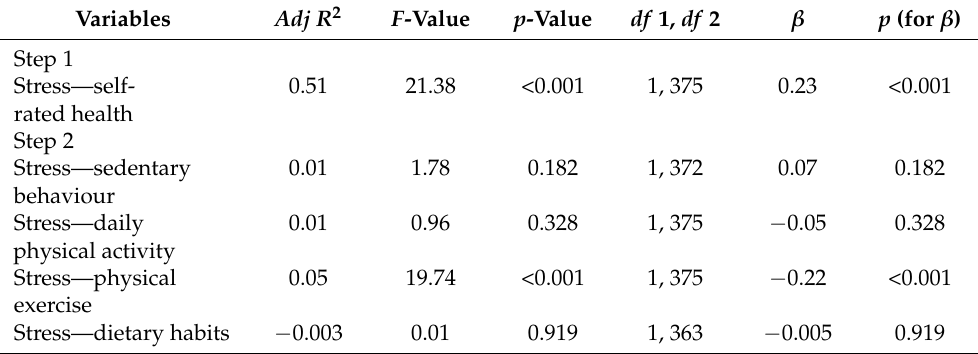
Table 6. Simple regression analyses for participants who reported two of the requested diagnoses (steps 1 and 2).